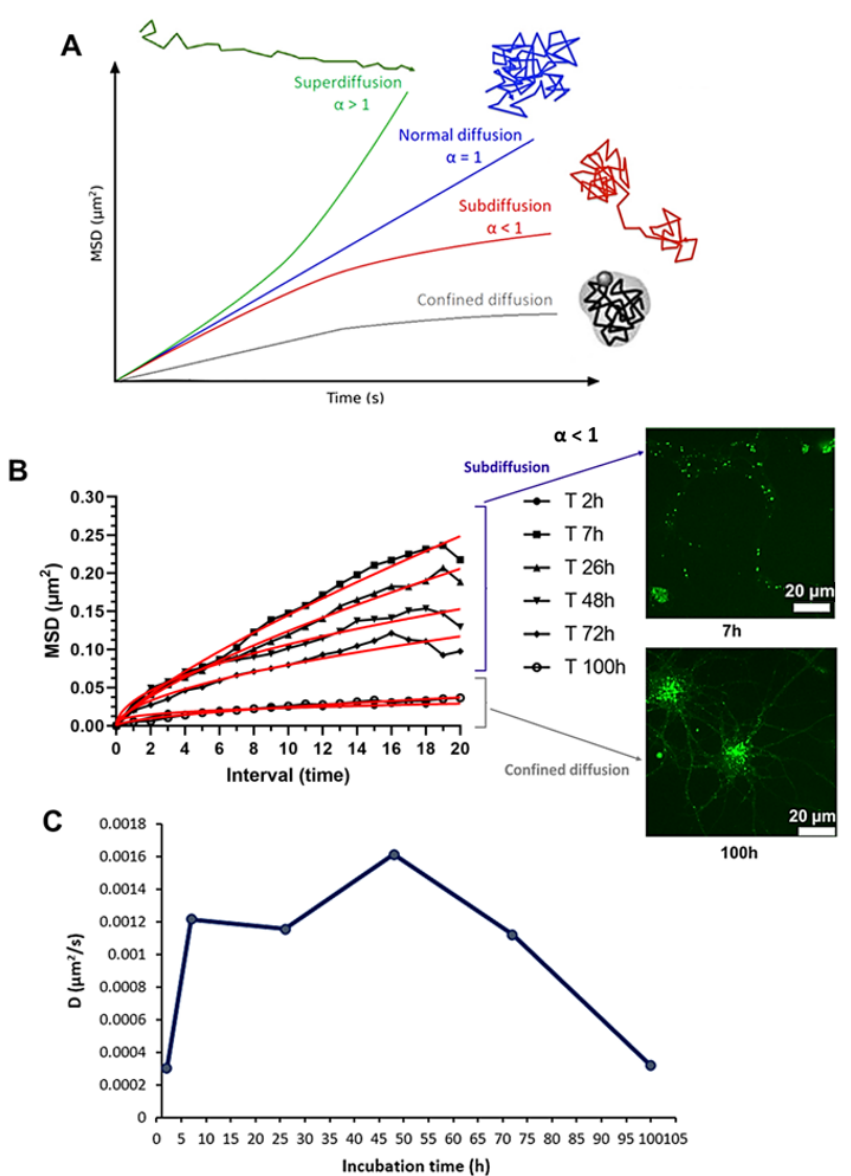
Figure 2. Mean square displacement (MSD). ( A ) MSD: type of diffusion and particle trajectory. The time dependence of the MSD characterizes the diffusional behavior of particles: a linear line (green) indicates normal diffusion (α = 1), a directed motion (blue) represents a superdiffusion (α > 1). When the MSD increases more slowly than for normal diffusion (α < 1), the particle can present a subdiffusion (red) or a confined diffusion (gray) (Adapted from Kapanidis et al . [40] which is licensed under a Creative Commons Attribution-(CC BY 4.0) International License). ( B ) MSD average curves of nanoliposomes at 2, 7, 26, 48, 72 and 100 h of incubation and representative fluorescence images of primary cortical neurons treated with NL at 7 and 100 h of incubation. NL labeled with ATTO 488 (green) (scale bar: 20 µm) are shown on the right to illustrate the subdiffusion (7 h, top) and confined diffusion (100 h, bottom). The mathematical adjustments (red curve) were obtained by applying formula 1 (section 2.10) to the raw data. ( C ) Diffusion coefficient of nanoliposomes at 2, 7, 26, 48, 72 and 100 h of incubation.